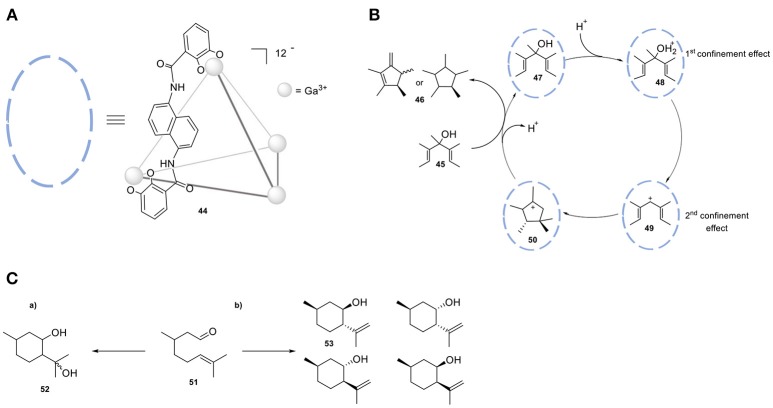
(A) Schematic model of tetrahedral cage 35 (Ga4L612-); only one ligand L is displayed as chemdraw structure for clarity. (B) Proposed catalytic mechanism of Nazarov of 1,3-pentadienols by utilizing cage 35. (C) Cyclization of monoterpene citronellal in the absence (a) and in the presence (b) of cage 35.